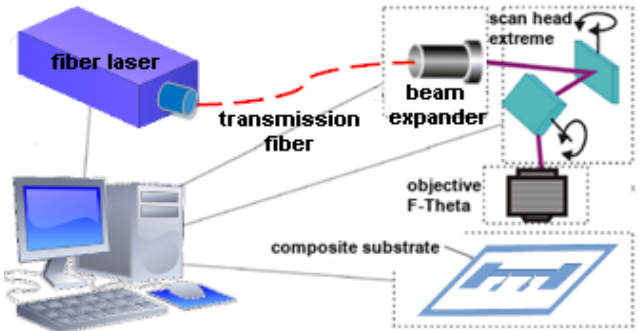
Figure 4. Single mode laser stand with Nutfield scan head and objective F-theta.